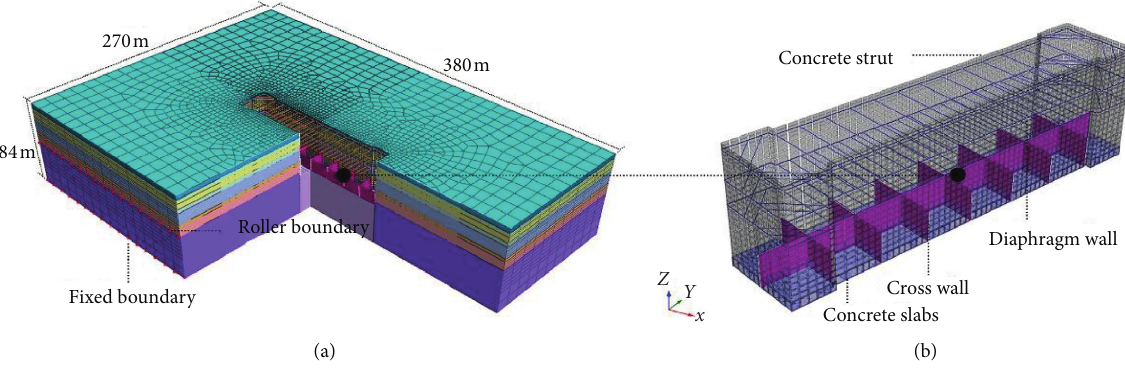
Figure 5: Three-dimensional finite element mesh for